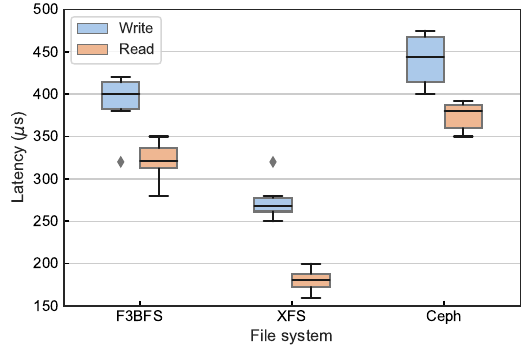
Figure 5. IOPS read/write latency in F3BFS, XFS, and